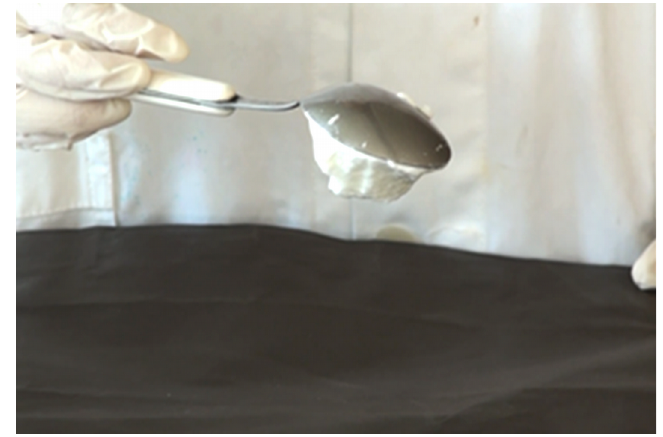
Figure 9. Preparation of meringue